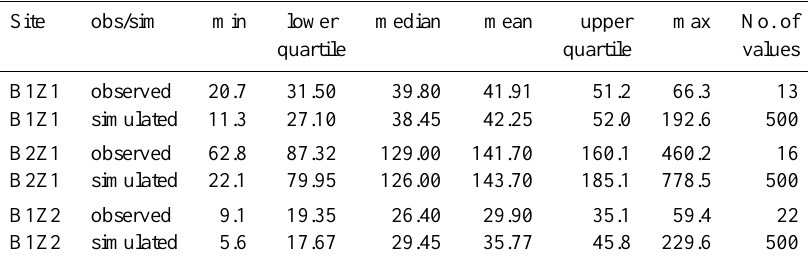
Table 7. Summary statistics for annual maximum flows (m 3 s − 1